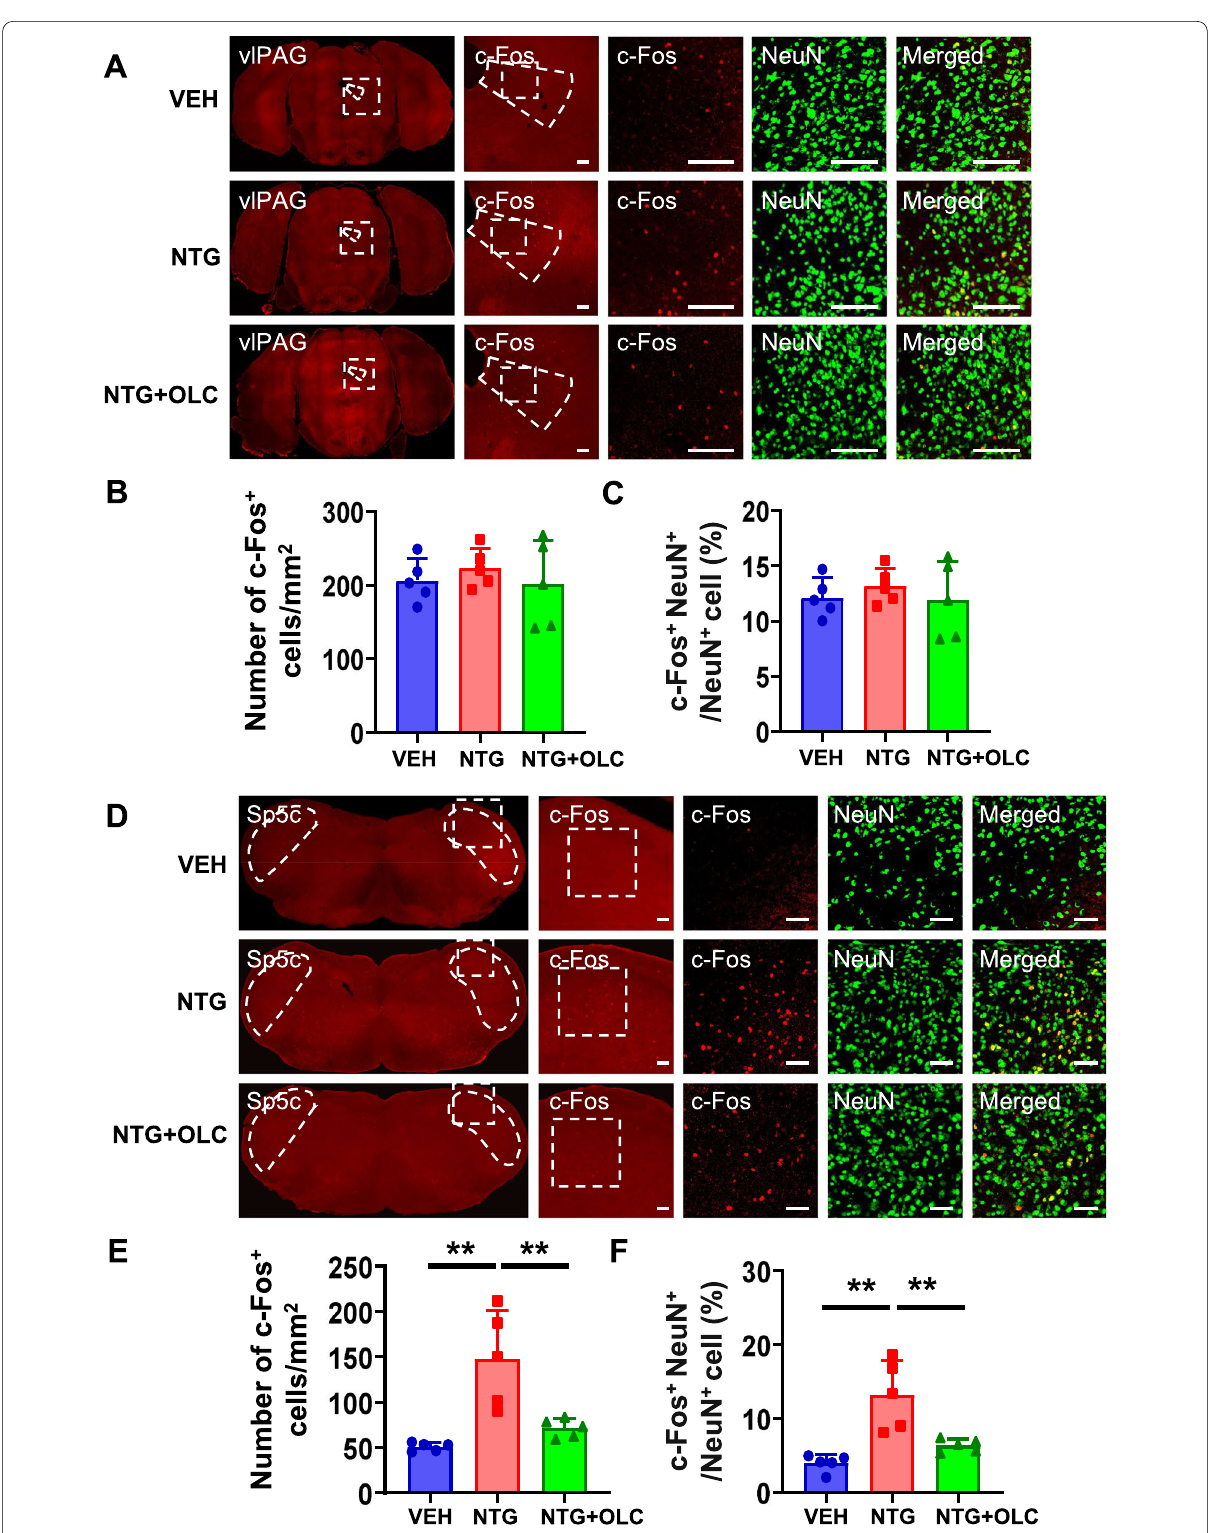
Fig. 4 (See legend on previous